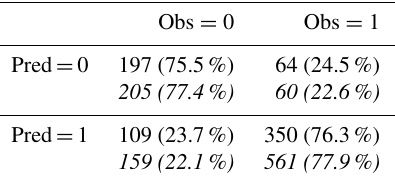
Table 4. Contingency table of observed (Obs) and predicted (Pred) Q bin for Algeciras (regular text) and Mula (italic text) with the num- ber of cases and percentage (in brackets) of true and false positives and